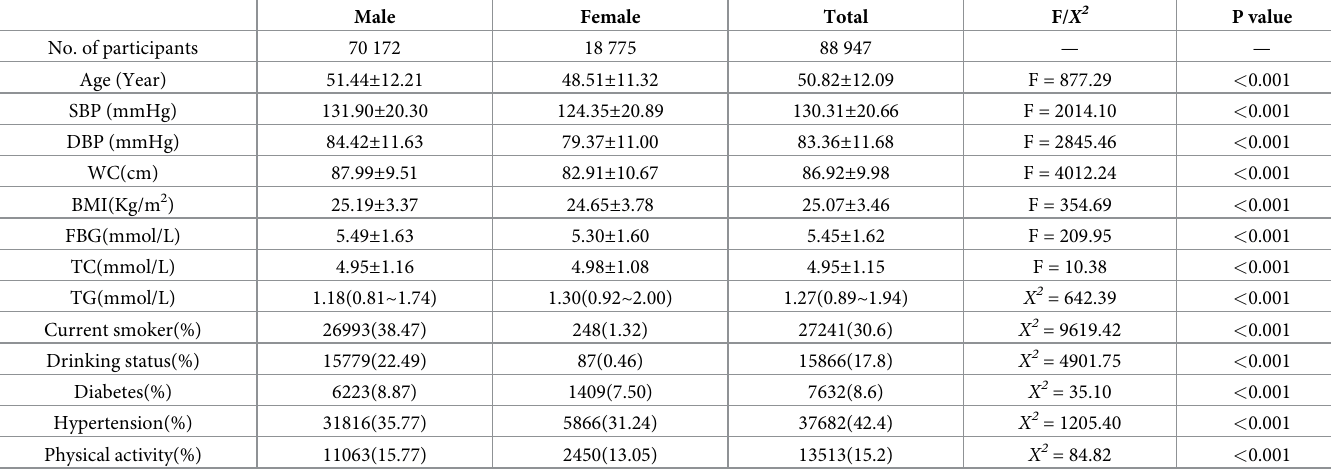
Table 1. Baseline characteristics of the population stratified by